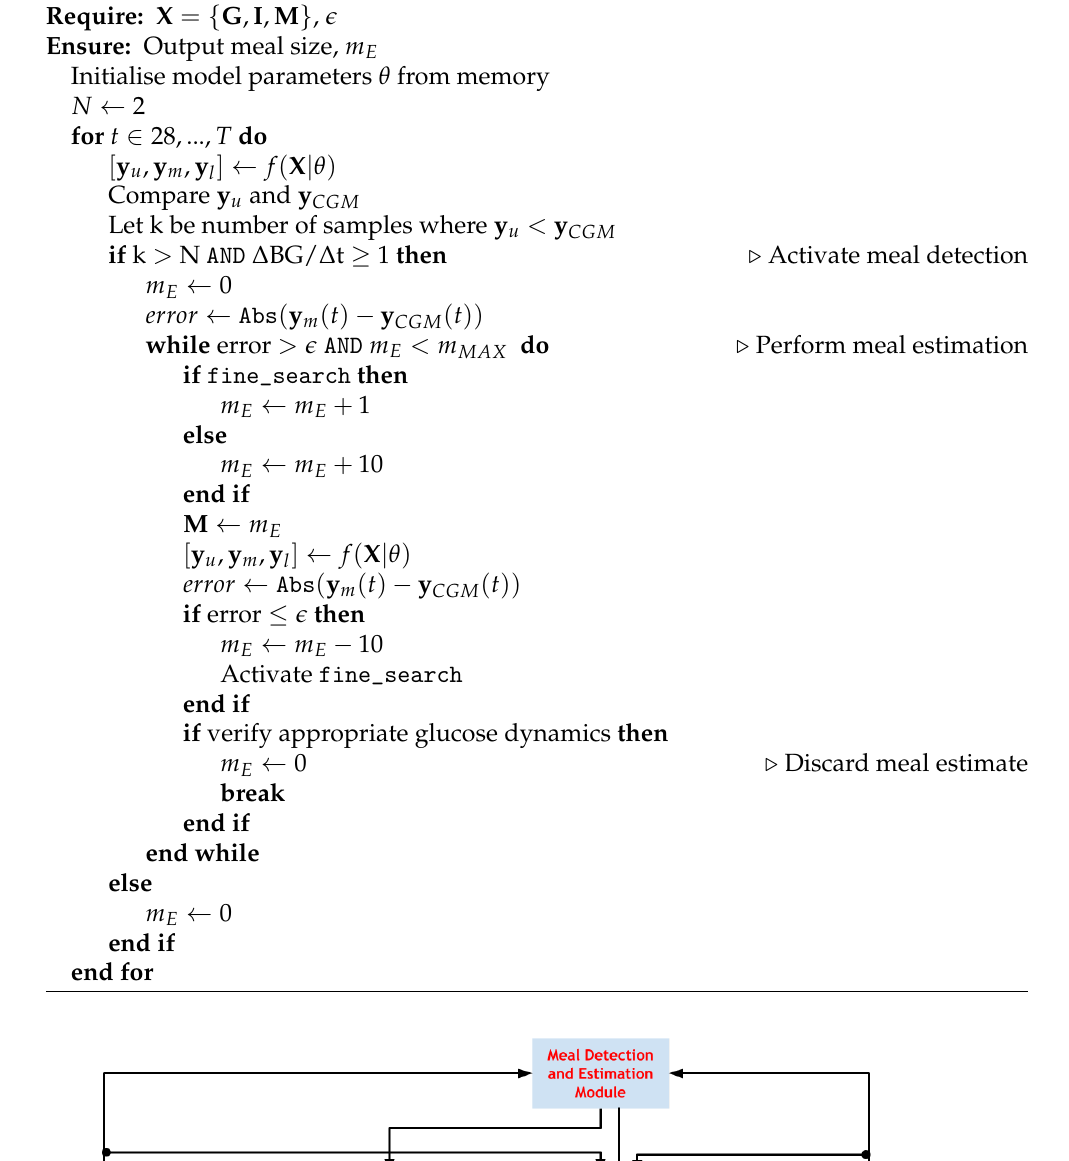
Algorithm 1 Meal Detection and Estimation Algorithm